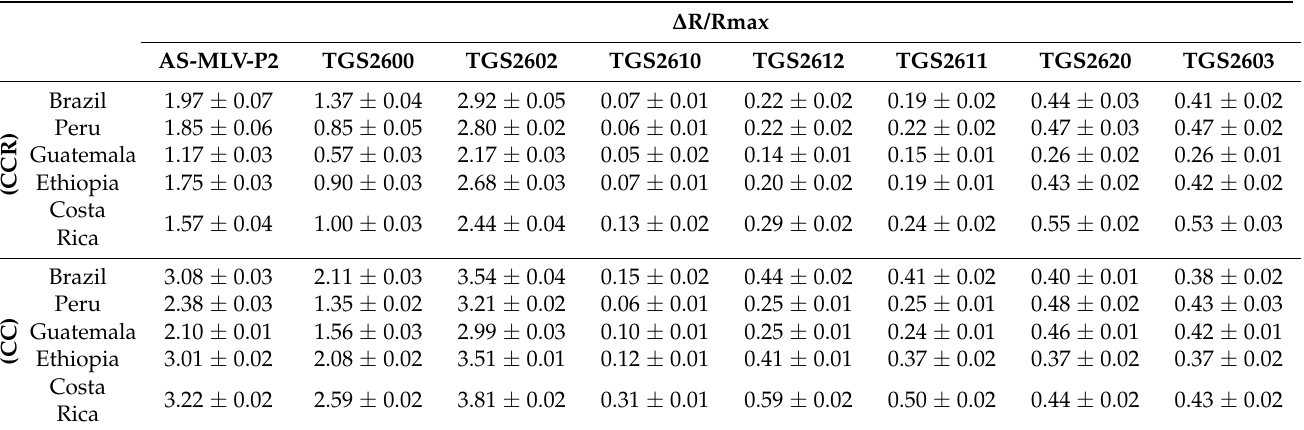
Table 2. Values of the maximum responses of chemically sensitive sensors to the intensity of aromas of Brazil Santos, Guatemala Comal, Costa Rica La Pastora, Ethiopia Sidamo, and Peru El Palto Organic coffee beans roasted in the CCR and CC